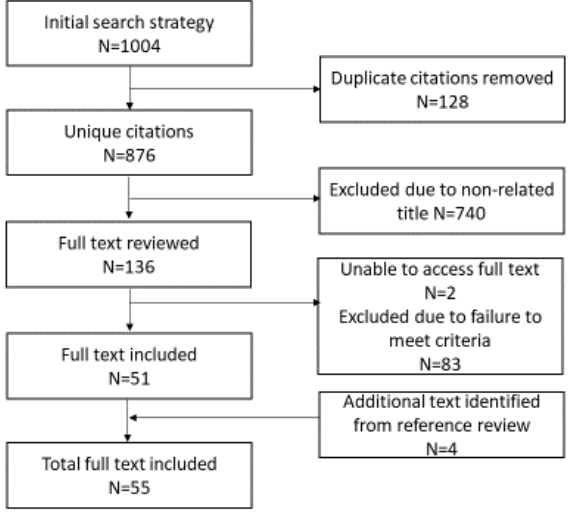
Figure 1. PRISM chart.